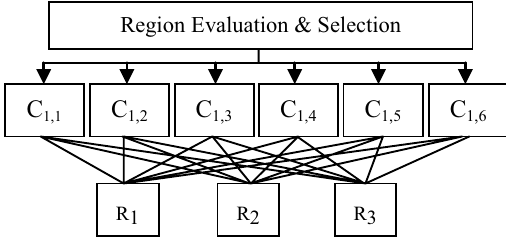
Fig. 2. Hierarchy for the region evaluation and selection